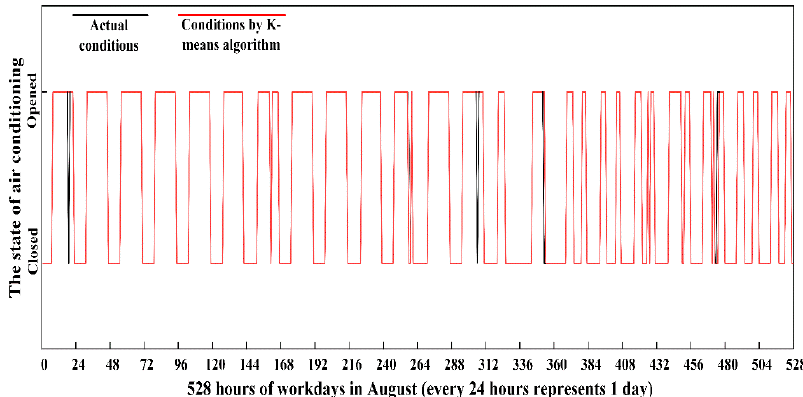
Figure 16. Comparison of identification results using the KNN method. Figure 13. Comparison of identification results using the KNN